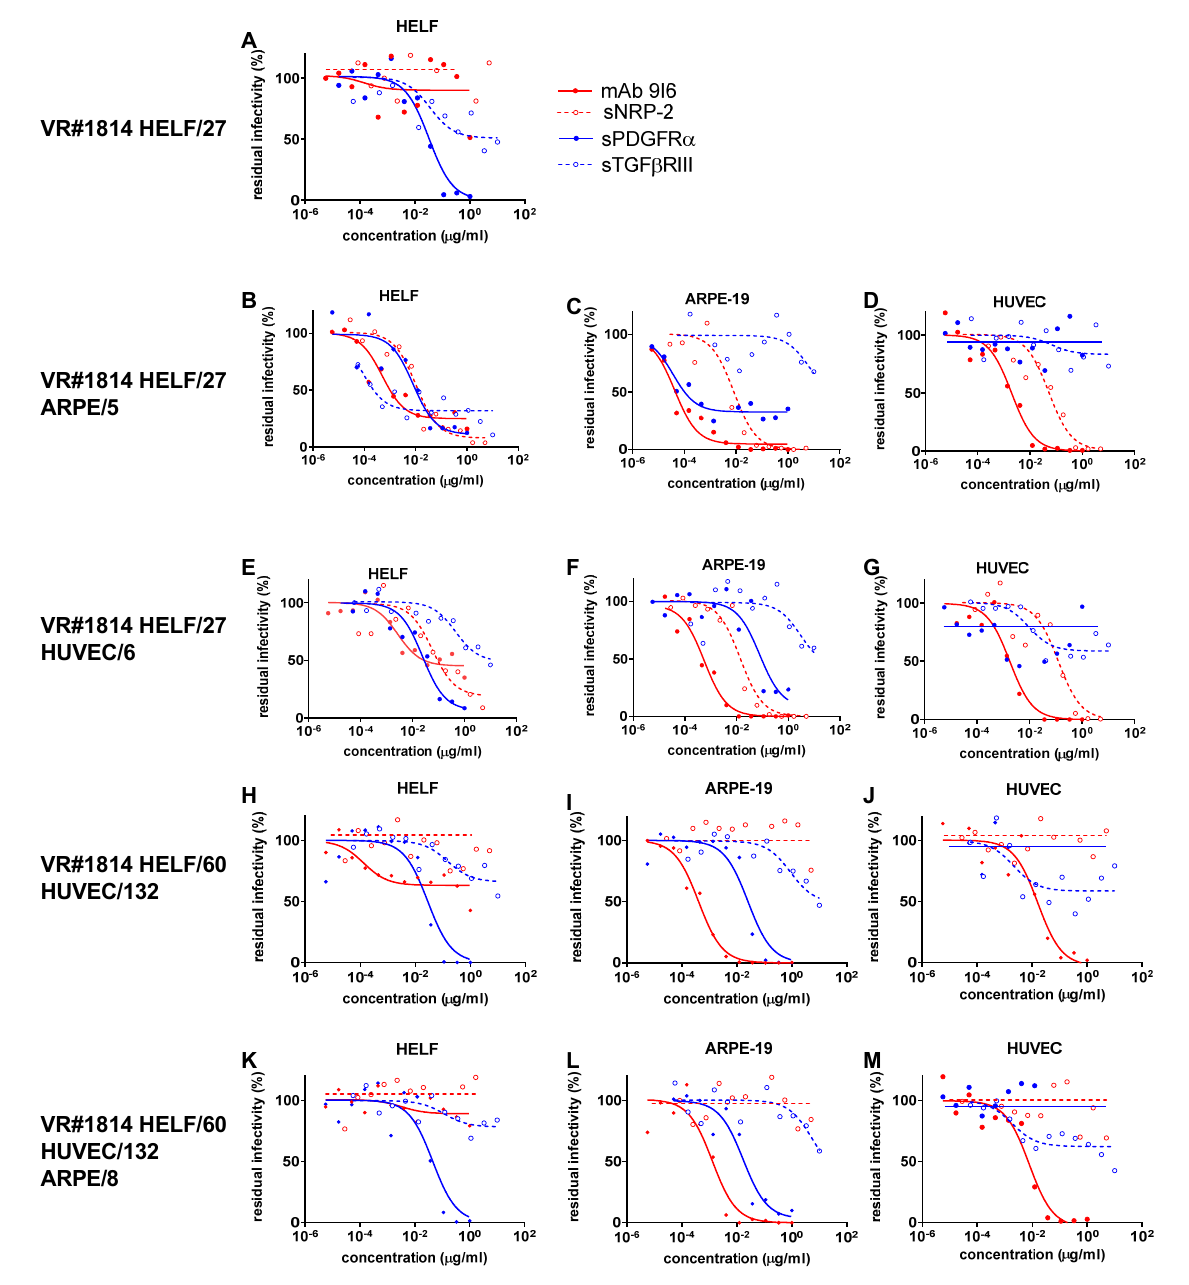
Figure 4. ICs 50 of anti-PC (mAb 9I6, and sNrp-2) and anti-TC (sPDGFR- α and sTGF β RIII) activity in inhibiting infectivity of reference strain VR#1814, which was recovered in HELF from cervical secretions and propagated in HELF/27 ( A ), and then in HELF/27 ARPE/5 ( B – D ) and HELF/27 HUVEC/6 ( E – G ), and finally passaged in HELF/60 HUVEC/132 ( H – J ) primary cells, and then, in HELF/60 HUVEC/132 ARPE/8 ( K – M ). ICs 50 of different inhibitors were determined for each passage in HELF ( A , B , E , H , K ), ARPE-19 ( C , F , I , L ), and HUVEC ( D , G , J , M ) cell substrates against residual infectivity.